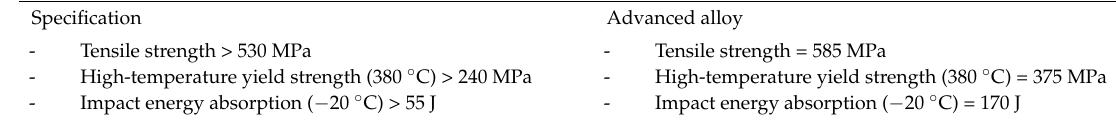
Table 3. Chemical composition and mechanical properties of selected alloys on the basis of the analysis performed.